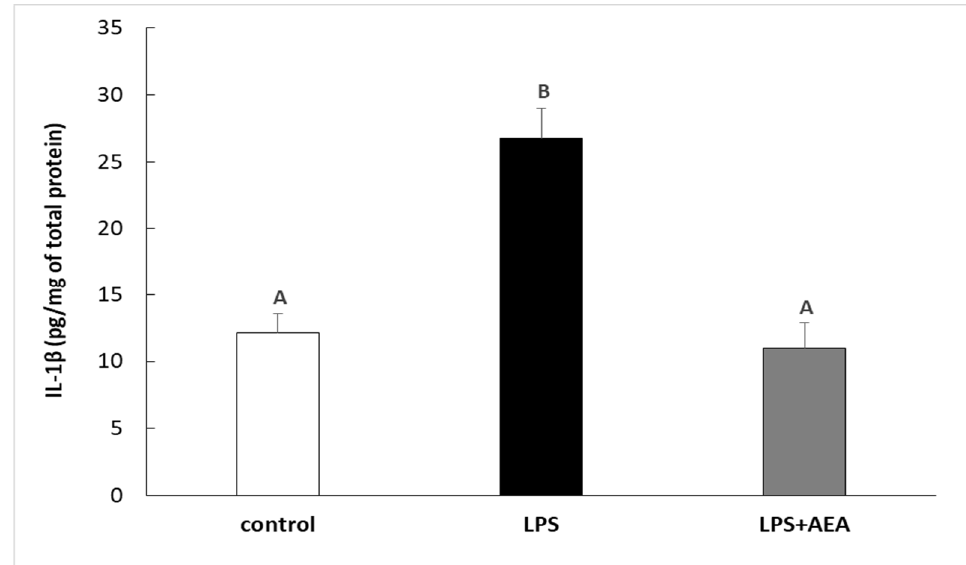
Figure 1. The effect of intravenous (i.v.) anandamide (AEA) injection (10 μ g/kg; i.v.) and lipopolysaccharide (LPS)-induced inflammation (400 ng/mg; i.v.) on the concentration of interleukin (IL)-1 β in the hypothalamus. Data are presented as the mean value ± S.E.M. Different letters indicate significant ( p < 0.05) differences according to a one-way ANOVA followed by Fisher’s least significance test.